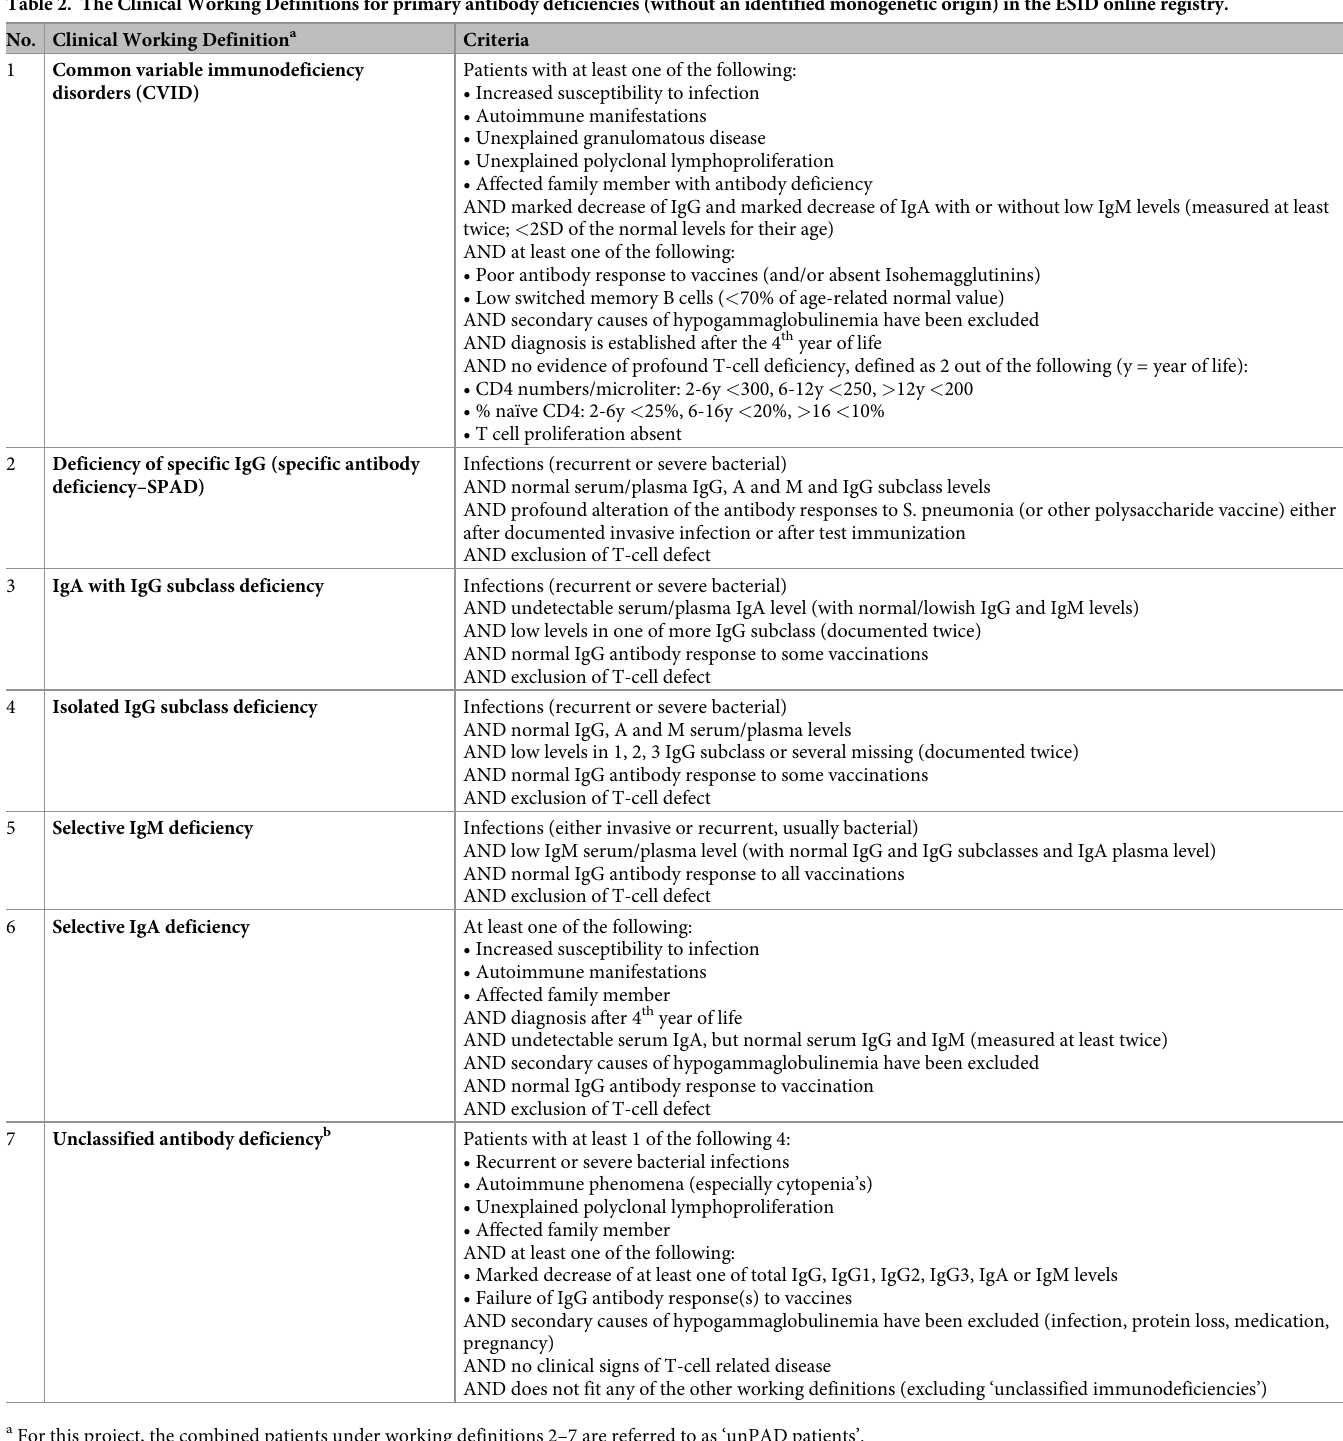
Table 2. The Clinical Working Definitions for primary antibody deficiencies (without an identified monogenetic origin) in the ESID online registry. No. Clinical Working Definition